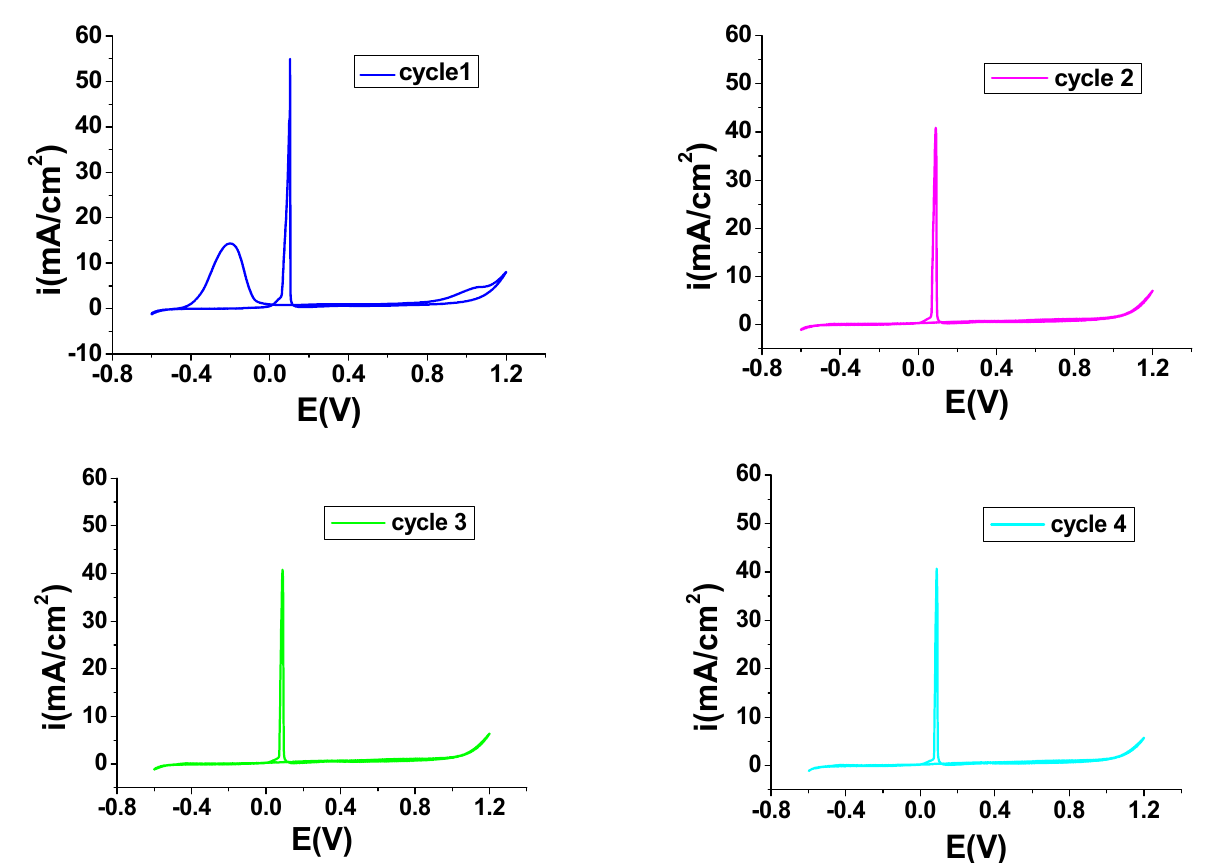
Figure 1. The voltammograms achieved at the polarization of OL 37 electrode in 0.3 M H 2 C 2 O 4 solution on the potential range of − 600 to +1200 mV at scan rate 20 mV/s at 4 cycles.